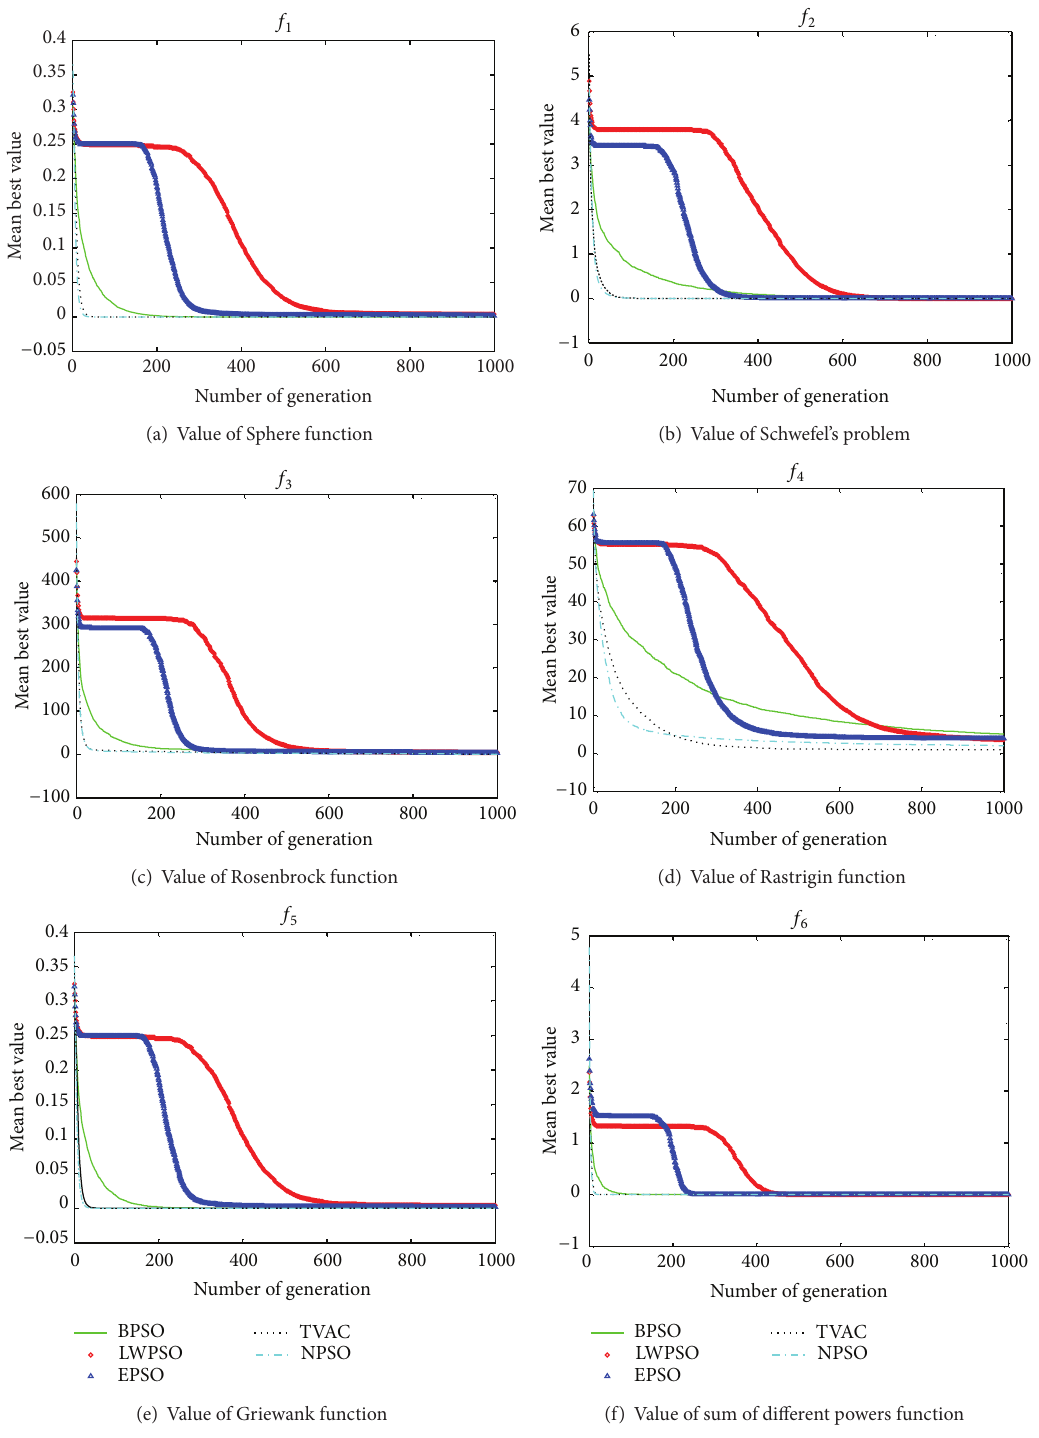
Figure 5: Variation of average optimum value with